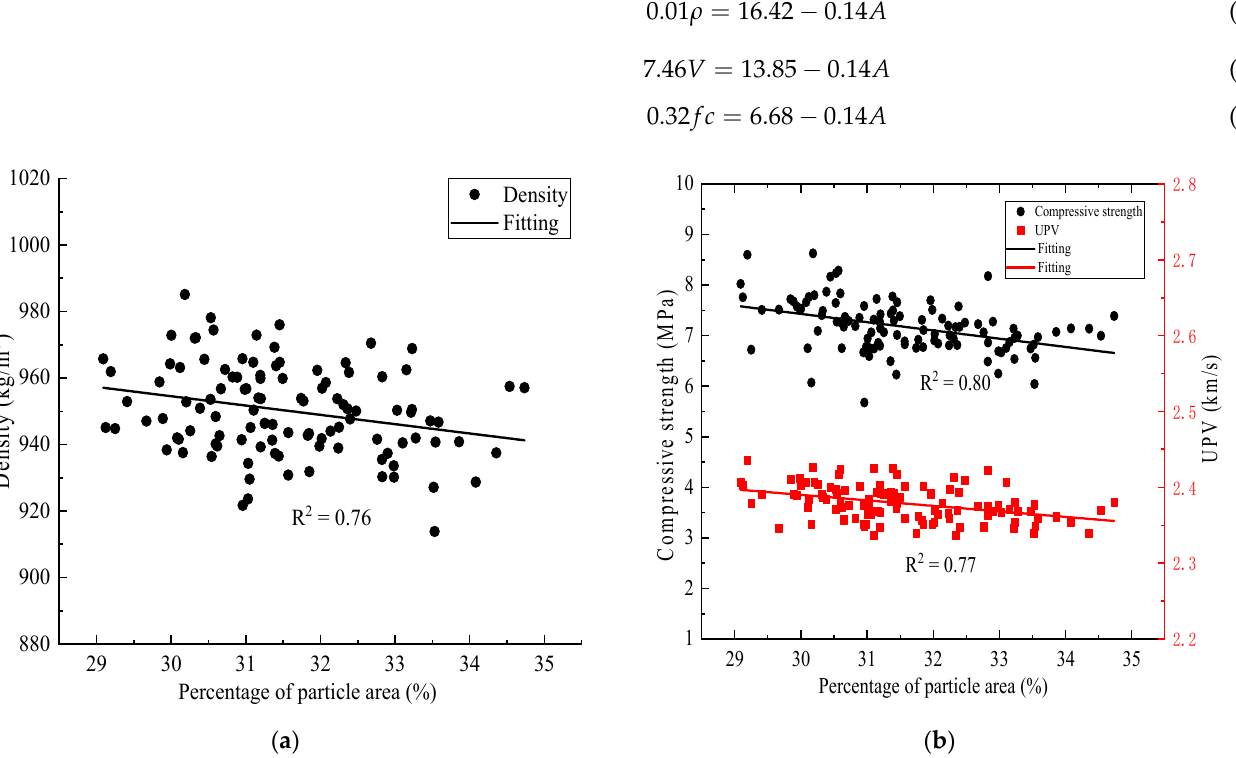
Figure 12. Parameter Correlation: ( a ) relationship between percentage of particle area and density; ( b ) percentage of particle area in relation to compressive strength and UPV.